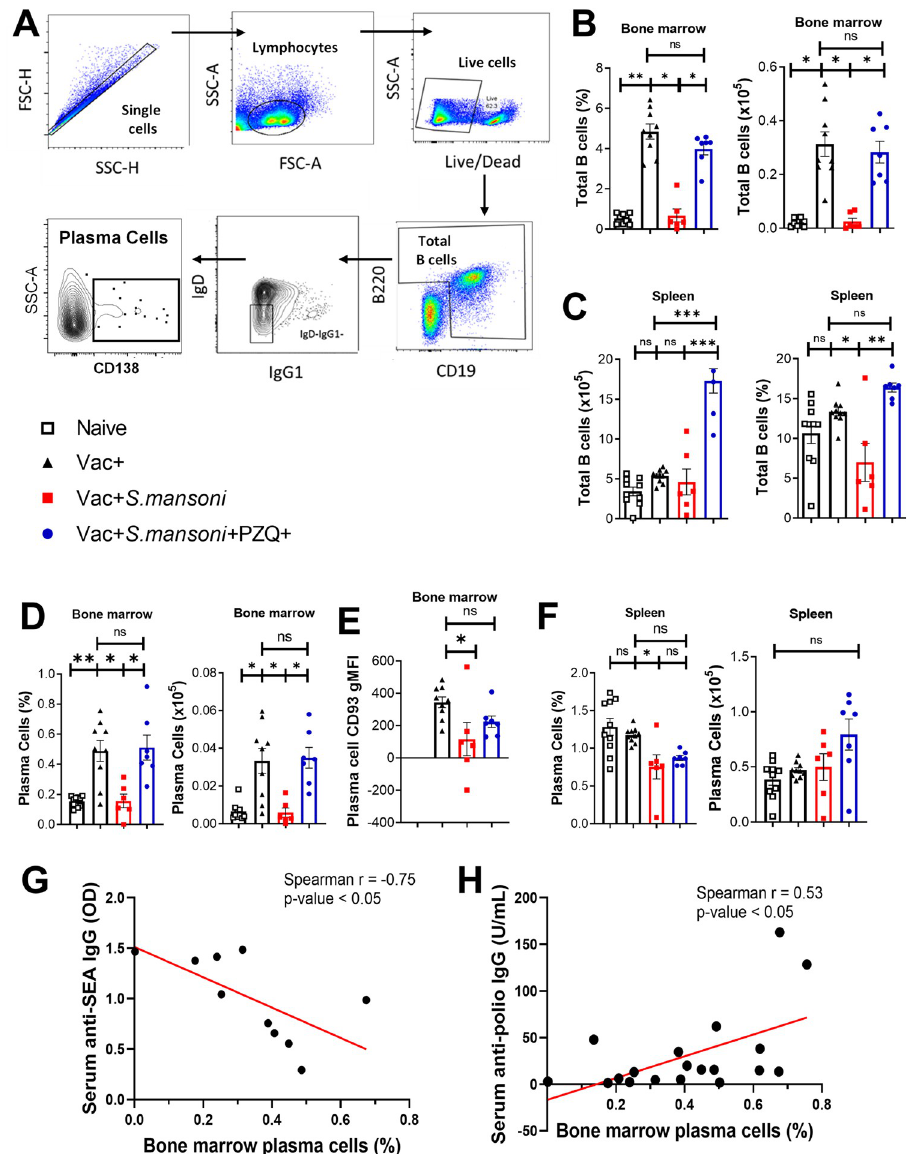
Fig 3. Total B cell and plasma B cell frequencies and counts at 18 weeks post schistosomiasis infection in the bone marrow and spleens of anti-Poliovirus vaccinated mice. (A) Representative gating strategy for plasma B cells. (B) Bone marrow total B cell frequencies and total numbers. (C) Spleen B cell frequencies and total numbers. (D) Bone marrow plasma B cells. (E) CD93 gMFI of bone marrow plasma B cells. (F) Spleen plasma B cells. Data are expressed as mean ± S.E.M and representative of 2 independent experiments (n = 6–10 mice per group in each experiment); Data was analysed by the Shapiro-Wilk test followed by either one way ANOVA with Bonferroni’s multiple comparisons test or by Kruskal Wallis followed by the Dunn’s multiple comparisons test; ns, p > 0.05; � p < 0.05, �� p < 0.001, ��� p < 0.0001; Vac, hexavalent (DTPa-hepB-IPV-Hib) vaccine; Sm, S . mansoni ; PZQ, praziquantel; CD93, cluster of differentiation 93. Increasing serum anti-SEA IgG titres are associated with reduced bone marrow plasma cell frequencies while increasing anti-polio IgG titres are associated with increasing bone marrow plasma cells. G. Anti-SEA titres vs bone marrow plasma cell frequencies of schistosomiasis infected Vac+Sm+ and Vac+Sm+PZQ + mice at week 18 p.i. H. Anti-polio IgG titres vs bone marrow plasma cell frequencies of Vac+, Vac+Sm+, and Vac +Sm+PZQ+ mice combined. G-H: Data are representative of 2 independent experiments (n = 4–10 mice per group); Data was analysed by Spearman’s correlation.